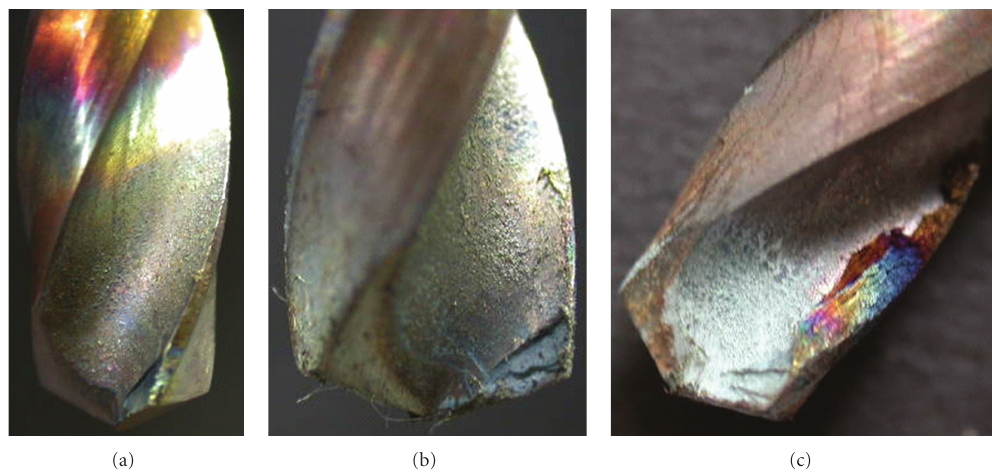
Figure 7: Di ff erent drills showing tool wear. Notice the zones with loss of TiN